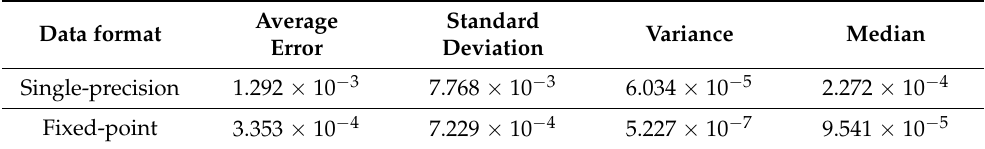
Table 1. Statistical analysis of data formats.